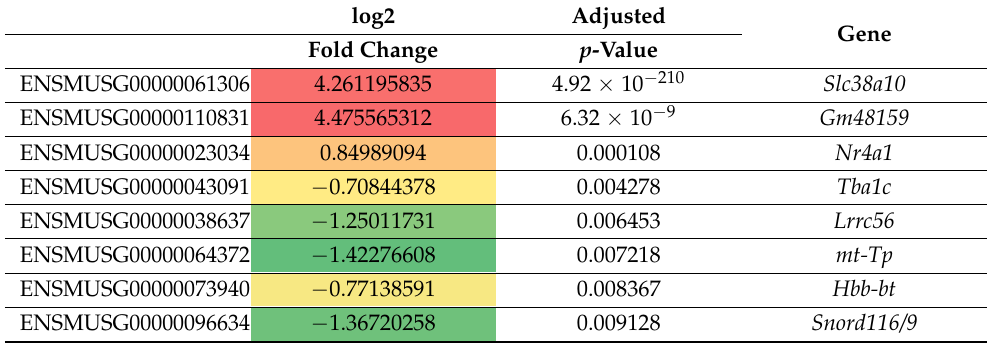
Table 2. Results from mRNA sequencing of the whole brain. Brains from adult male mice (4 WT, 4 KO) were dissected and RNA was extracted and used for mRNA sequencing. The mRNA sequences that were significantly altered in SLC38A10-deficient mice are shown in the table. Note that analysis is performed with KO set as control; hence, the log2 fold change is in WT brains compared to KO. Red color signifies an upregulation and green color a